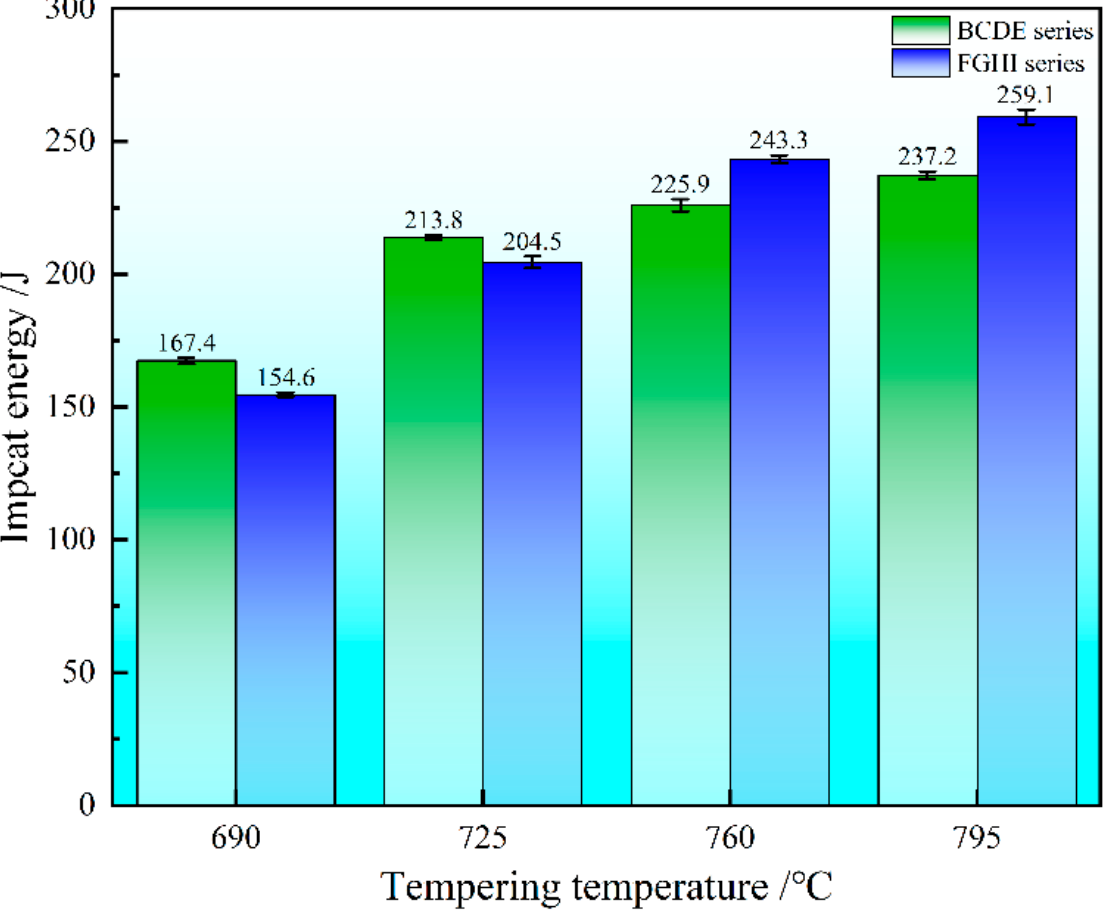
Figure 8. Effect of tempering temperature on the impact energy of alloys.